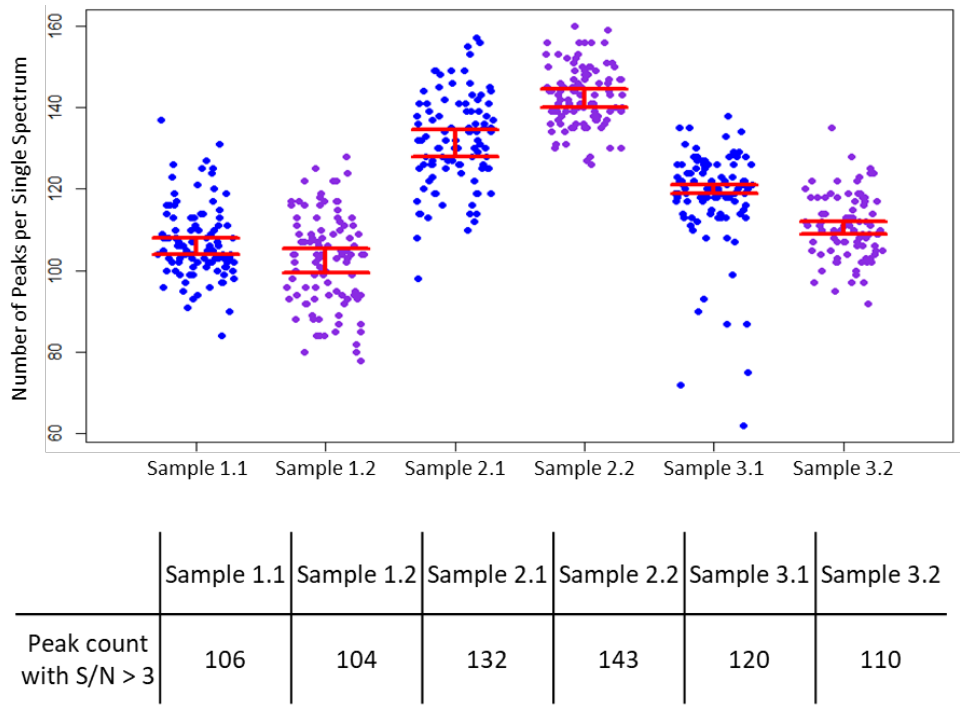
Figure 3. Peak count comparison from cytospin processed sample 1.1 with its duplicate 1.2 (AMO BZB), sample 2.1 and its duplicate 2.2 (AMO WT), and sample 3.1 with its duplicate 3.2 (H929 GFP/LUC). From each sample, 100 random spectra were used to calculate the number of peaks per single spectrum, with S/N > 3 and m/z > 500 < 3200. Sample 2 showed the highest number of peaks (peaks = 132 in replicate 2.1, peaks = 143 in replicate 2.2) compared to sample 1 (peaks = 106 in replicate 1.1, peaks = 104 in replicate 1.2) and sample 3 (peaks = 120 in replicate 3.1, peaks = 110 in replicate 3.2).